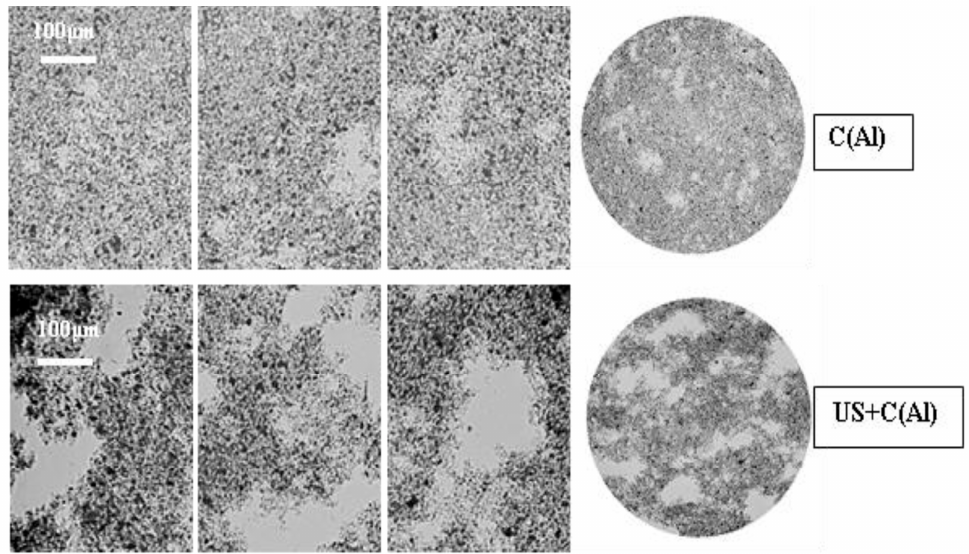
Figure 6. Post-coagulation sludge structure after using aluminum sulfate (Al): without ultrasound exposure (C(Al)) and with ultrasound exposure (US/C(Al)) .